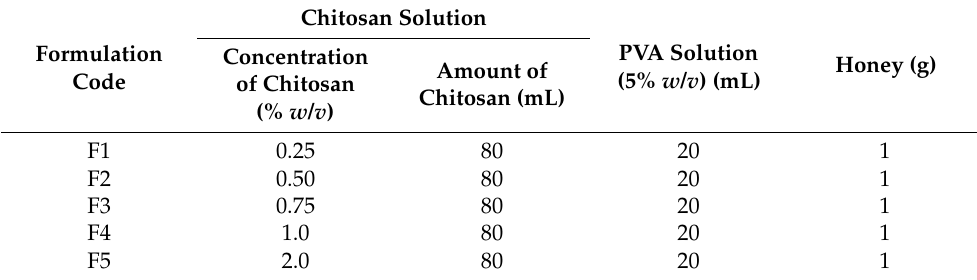
Table 7. Composition table for preparing different batches of hydrogel films.